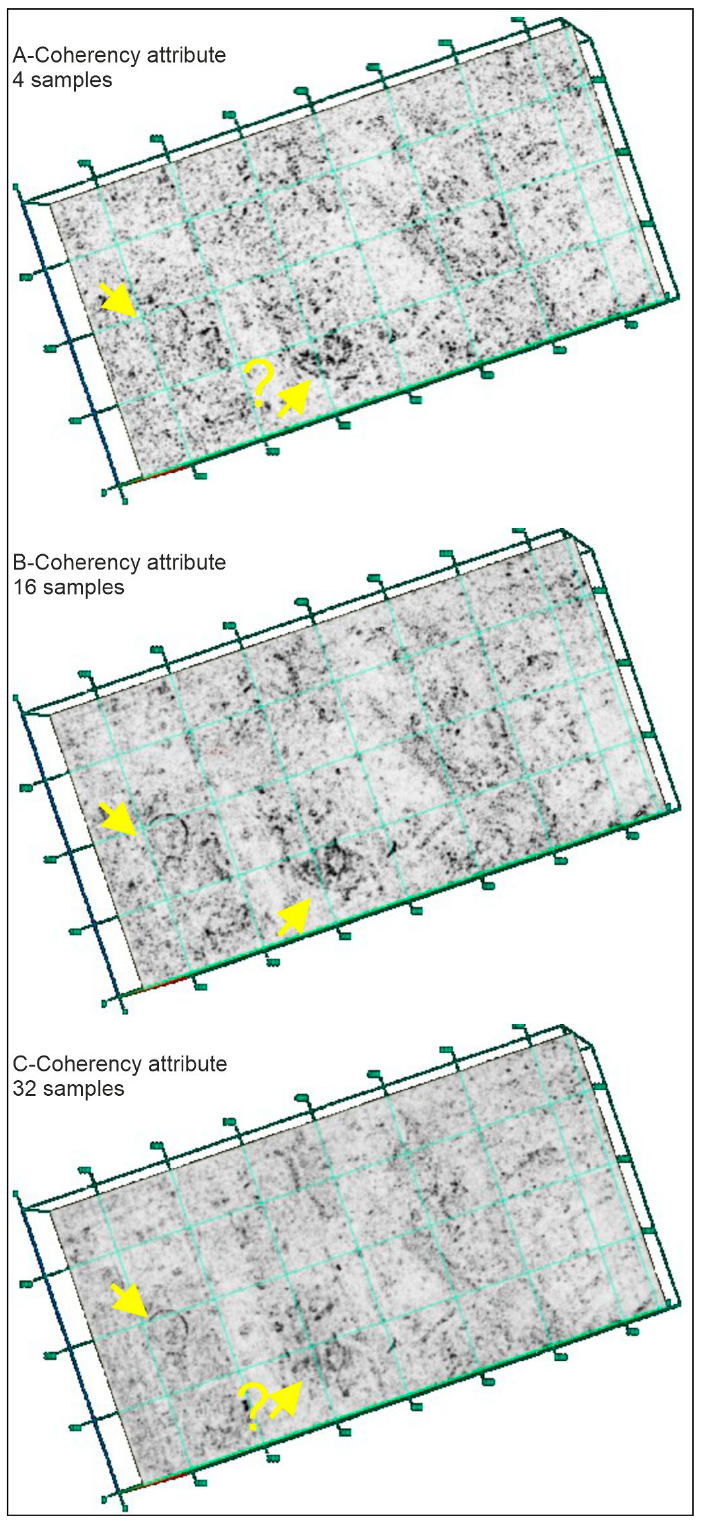
Figure 7. Coherency attribute calculation using the same 5 by 5 matrix pattern, but with different numbers of vertical samples: 4 ( A ), 16 ( B ), 32 ( C ). Yellow arrows point to two structures, while question marks refer to situations in which the coherence is low.